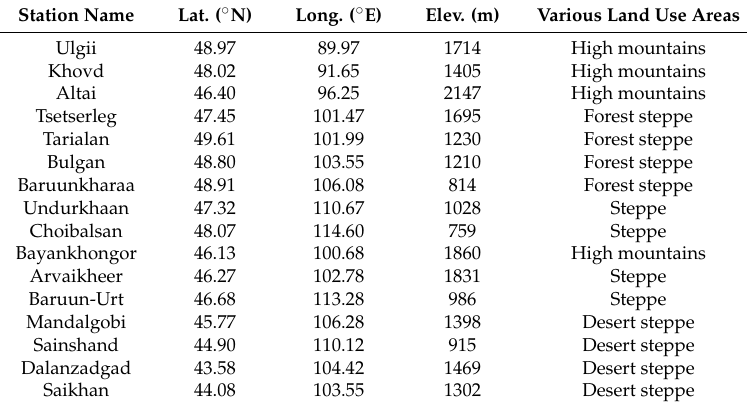
Table 1. Meteorological observation stations with information about the geographical location, elevation and various land use areas of